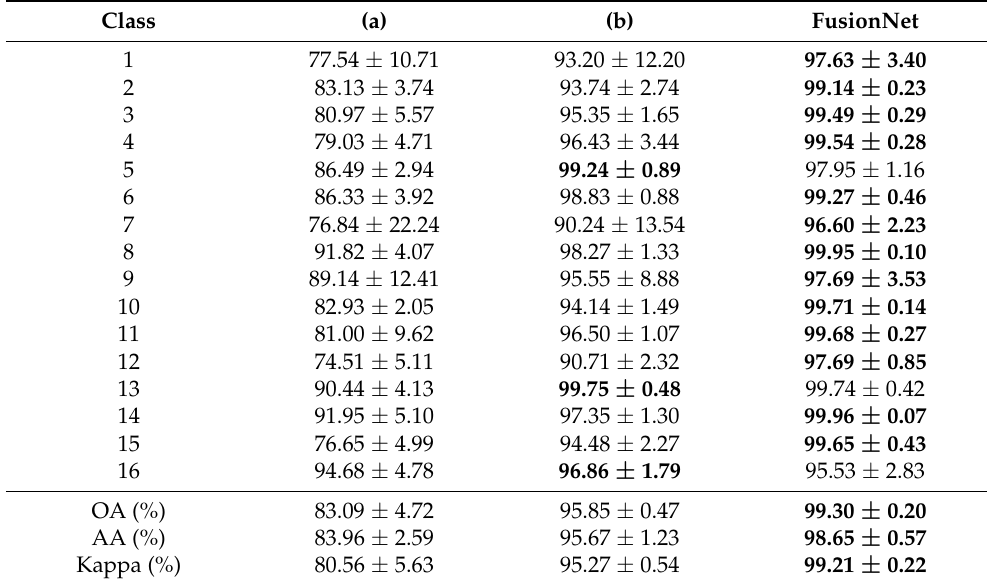
Table 8. Comparison results of (a), (b), and the original FusionNet on the Indian Pines dataset.